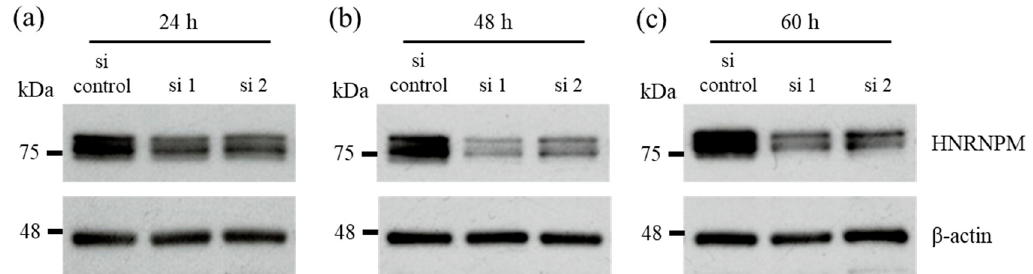
Figure 2. Knockdown of HNRNPM protein expression. Cells were pre-treated with an siRNA against HNRNPM or a non-targeting siRNA and incubated for 24 h ( a ), 48 h ( b ), and 60 h ( c ) under low-glucose conditions. The effect of the knock- down of HNRNPM protein expression was detected using western blotting. si control: non-targeting siRNA-transfected cells, si 1: HNRNPM siRNA (SASI_Hs01_00049126)-transfected cells, and si 2: HNRNPM siRNA (SASI_Hs01_00049128)- transfected cells.